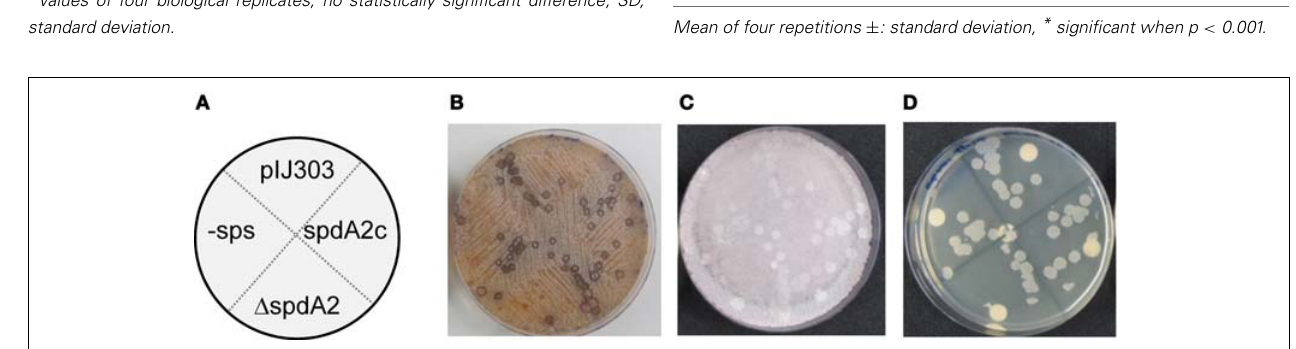
FIGURE 4 | Genetic crosses to visualize transfer and intramycelial plasmid spreading of pIJ303 and its derivatives. Dilutions of S. lividans TK54 containing derivatives of plasmid pIJ303 (thio R ) were streaked on a lawn ( ∼ 10 6 spores) of plasmid free TK64::pSET152 (apra R ) on R5 plates, as schematically illustrated (A) . Pock structures associated with the conjugative plasmid transfer were visible after